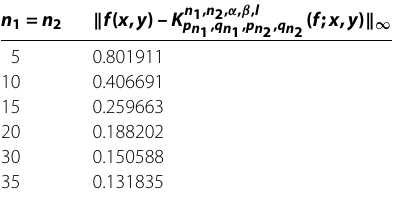
Table 1 The errors of the approximation of K n 1 , n 2 , α , β , l p q n = q n = 0.9999, l = 1, α = 3, β = 2 and different values of n 1 , n 2 1 2